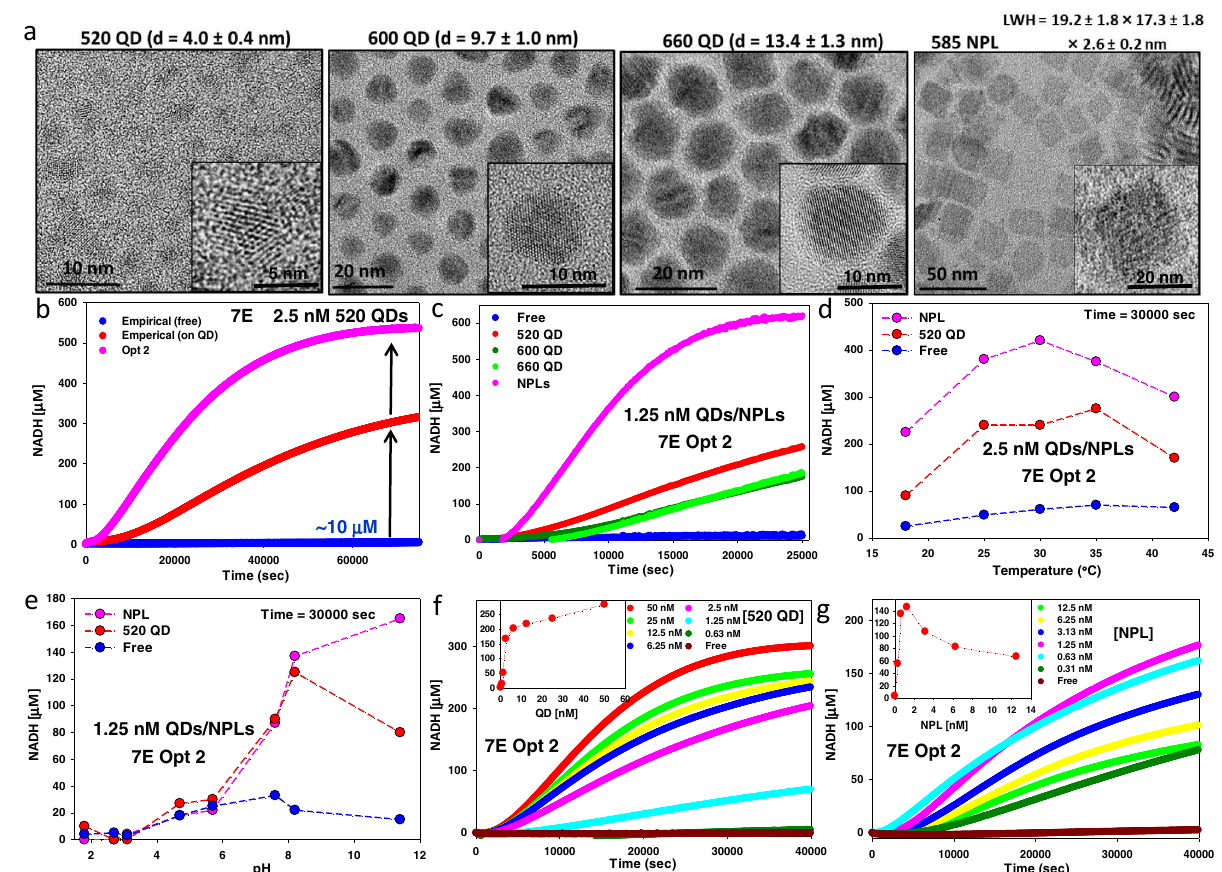
Fig.3|Nanoparticlesandcatalyticperformanceinthe7enzymeglucose → 3-PG cascade. a TEMmicrographsofthe QD andNPLmaterialsutilized along withtheir average diameter (d) or size. Representative high-resolution micrograph shown inset. LWH=length×width×height. The terms QD and NPL distinguish each material, while NP refers to them collectively. b Representative progress curve measuring NADH conversion over time for 520 QD clusters assembledwith the 7E system (glucose → 3-PG) at empirical enzyme ratios (red) vs. same enzyme free in solution (blue). 10 μ M indicates the fi nal amount of NADH converted in the free enzyme assay. Progress curves assembled using optimized enzyme ratios per QD determined after two consecutive rounds of numerical simulation (pink - Opt 2). Freeenzymecontrolsforoptimizationhadidenticalresultsasthatoftheempirical sample. 520 QD concentration=2.5nM. c Progress curve comparing NADH con- versionusingOpt2enzymeratioswiththethreedifferentsizedQDsamples,NPLs, and free enzyme. QD/NPL=1.25nM. d NADH conversion at 30,000s for 2.5nm